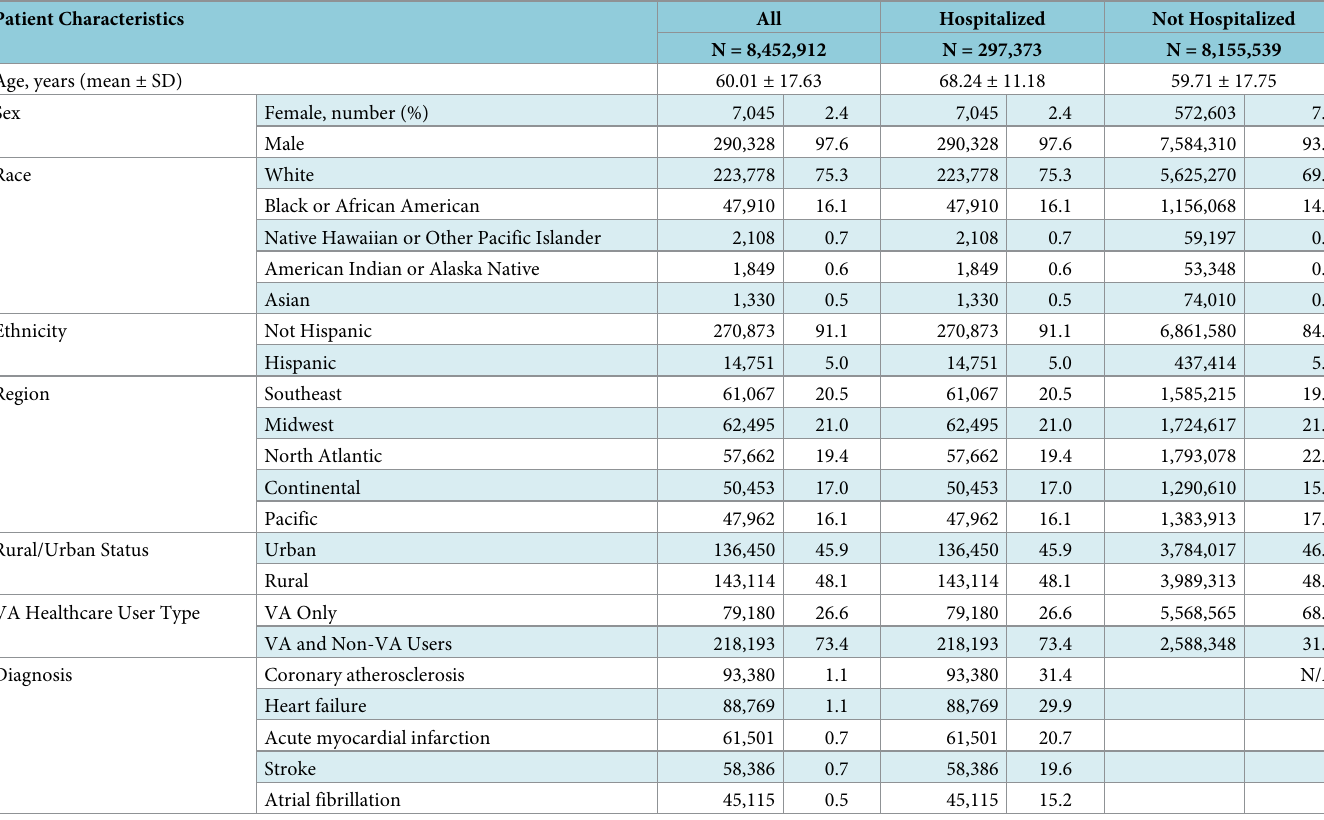
Table 1. Characteristics of veterans hospitalized vs. not hospitalized for one of the top 5 cardiovascular conditions between 2010 and 2014 (cid:3) †. Patient